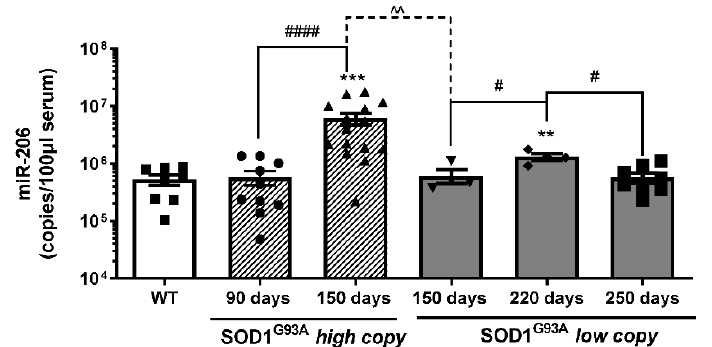
Figure 3. Serum levels of mir-206 are differently modulated during ALS disease progression. Absolute quantification of miR-206 levels in SOD1 G93A high-copy and SOD1 G93A low-copy mice at different stages of the disease (* comparison vs. control: ** p < 0.005, *** p < 0.0005. ^ and # comparison between groups: ^^ p < 0.005 # p < 0.05, #### p < 0.0001. •, ▲ , ▼ , , ■ , represent samples of WT control mice,